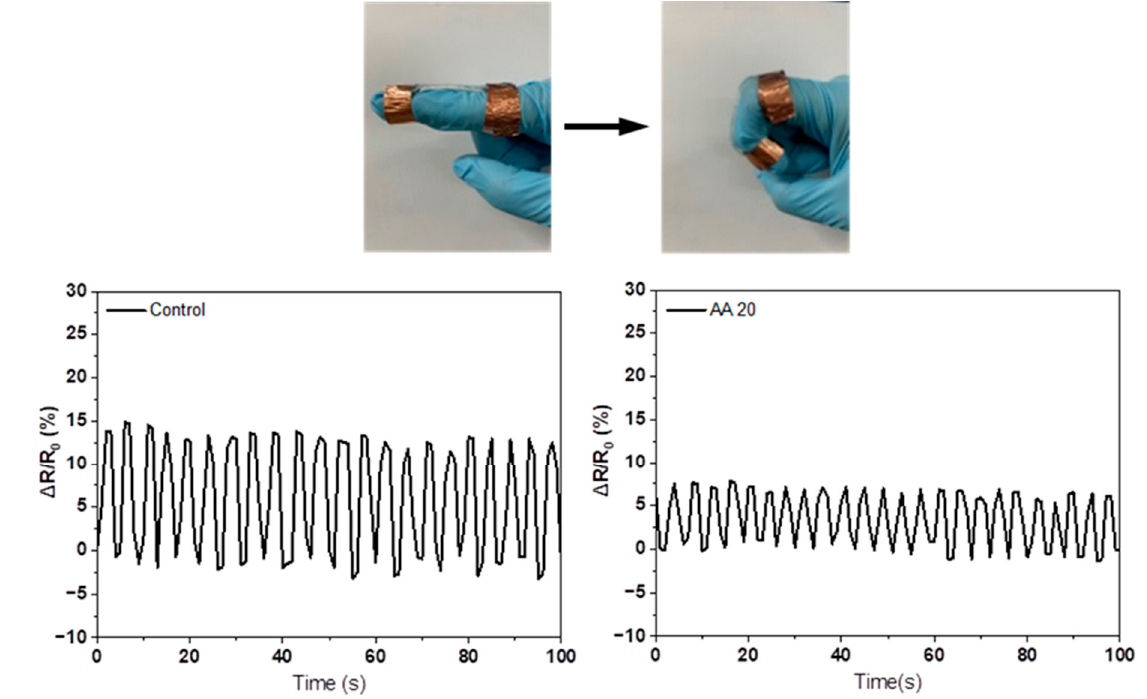
Figure 11. Change in resistance of the control and AA20 hydrogels.